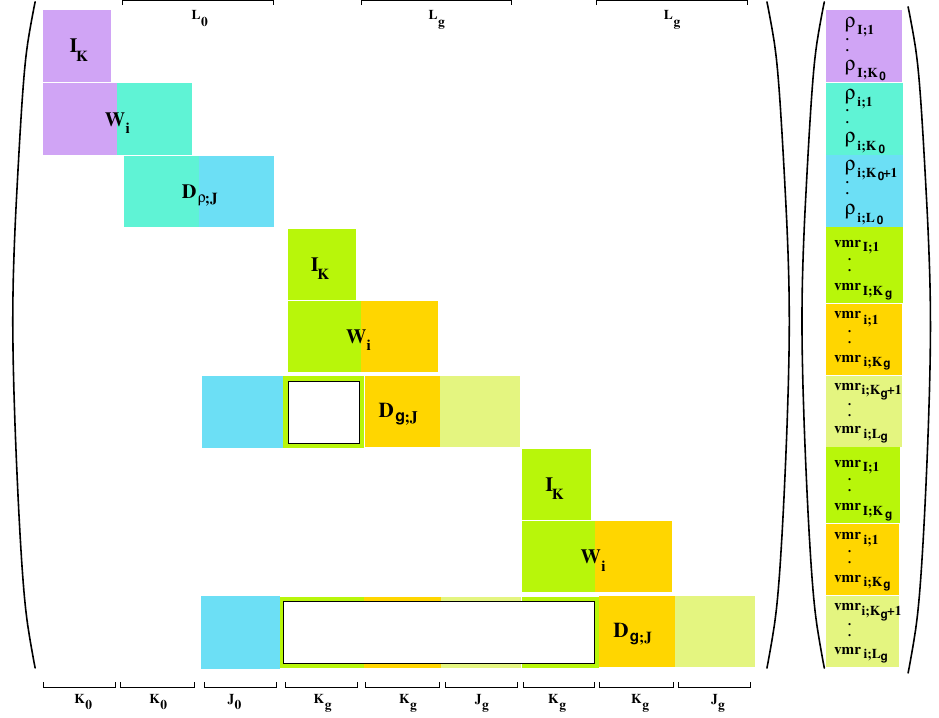
Figure 1. Matrix structure of the right-hand part of Eq. (28). Colors indicate which matrix blocks operate on which part of the input vector. An example with two gases is